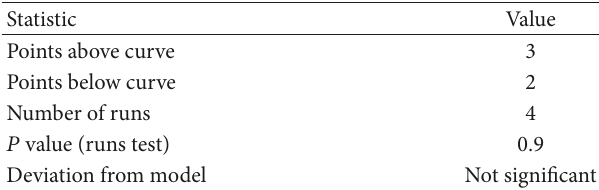
Table 3: Results of the runs